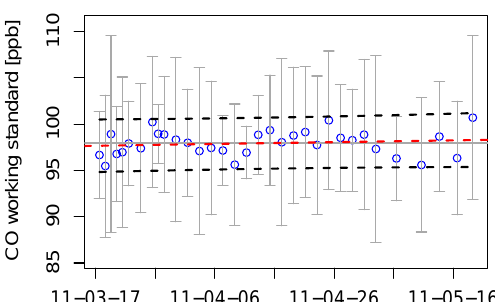
Fig. 4. Reproducibility of a 97.9-ppb working standard measured with a CRDS instrument over the period of 2 months. Each mea- surement (open blue circles) denotes the average of ten 1-min val- ues. The individual error bars indicate the uncertainty of these mea- surements ( k =2); the red dotted line is the linear regression over time, and the black dotted lines are the 95% confidence bands of the linear